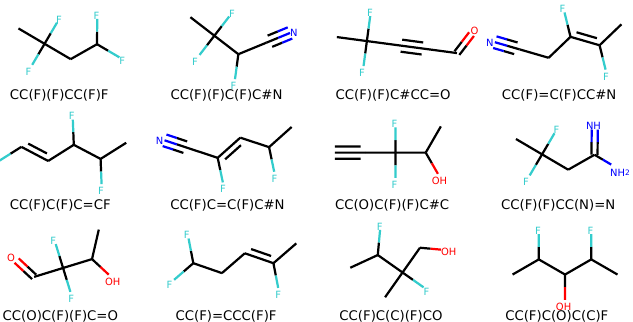
Figure 6. Molecules similar in latent space using the can2can model. The reference molecule is in the upper left corner and similarity drops row-wise in normal reading direction.